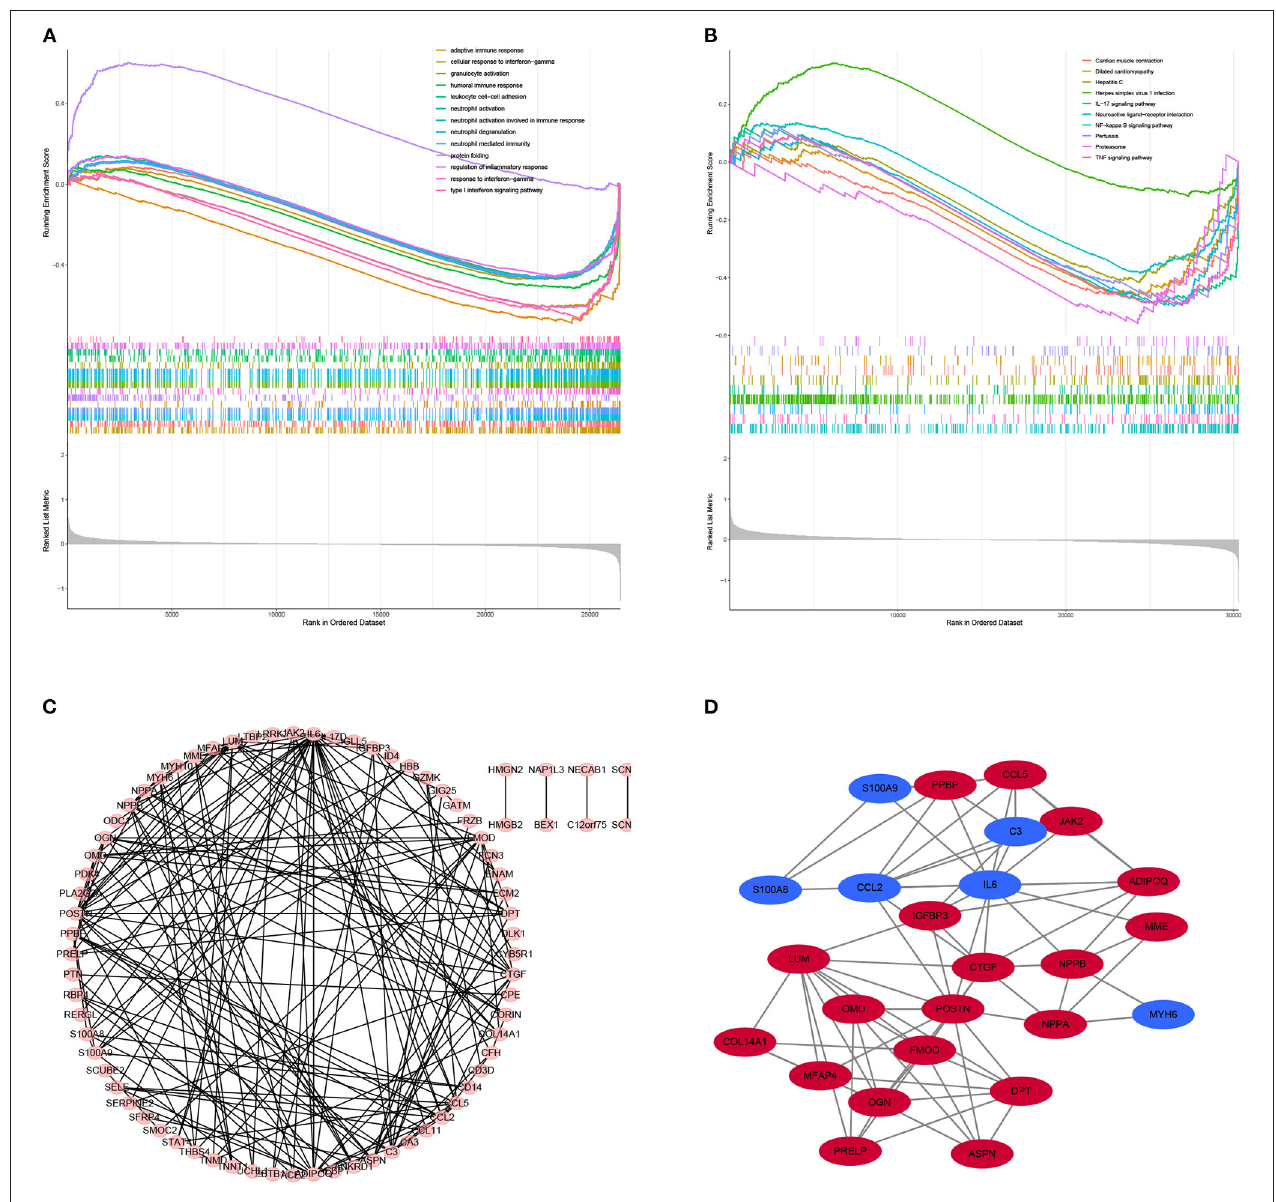
FIGURE 3 | Results of Gene Set Enrichment Analysis (GSEA) plots showing the most enriched gene sets of all detected genes in the DCM cardiac tissues and normal cardiac tissues in an integrated analysis of four datasets. (A) The top three most significant up-regulated enriched gene sets in the biological processes: protein folding, humoral immune response, regulation of inflammatory response. (B) The top three most significant up-regulated enriched gene sets in the Kyoto Encyclopedia of Genes and Genomes analysis: Herpes simplex virus 1 infection, Neuroactive ligand–receptor interaction, IL − 17 signaling pathway. (C) PPI network of differentially expressed genes (DEGs). (D) Hub gene of differentially expressed